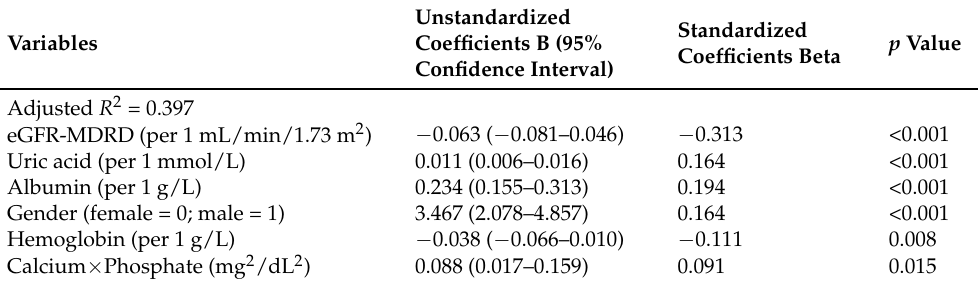
Table 4. Multivariable linear regression analysis for total homocysteine concentrations.